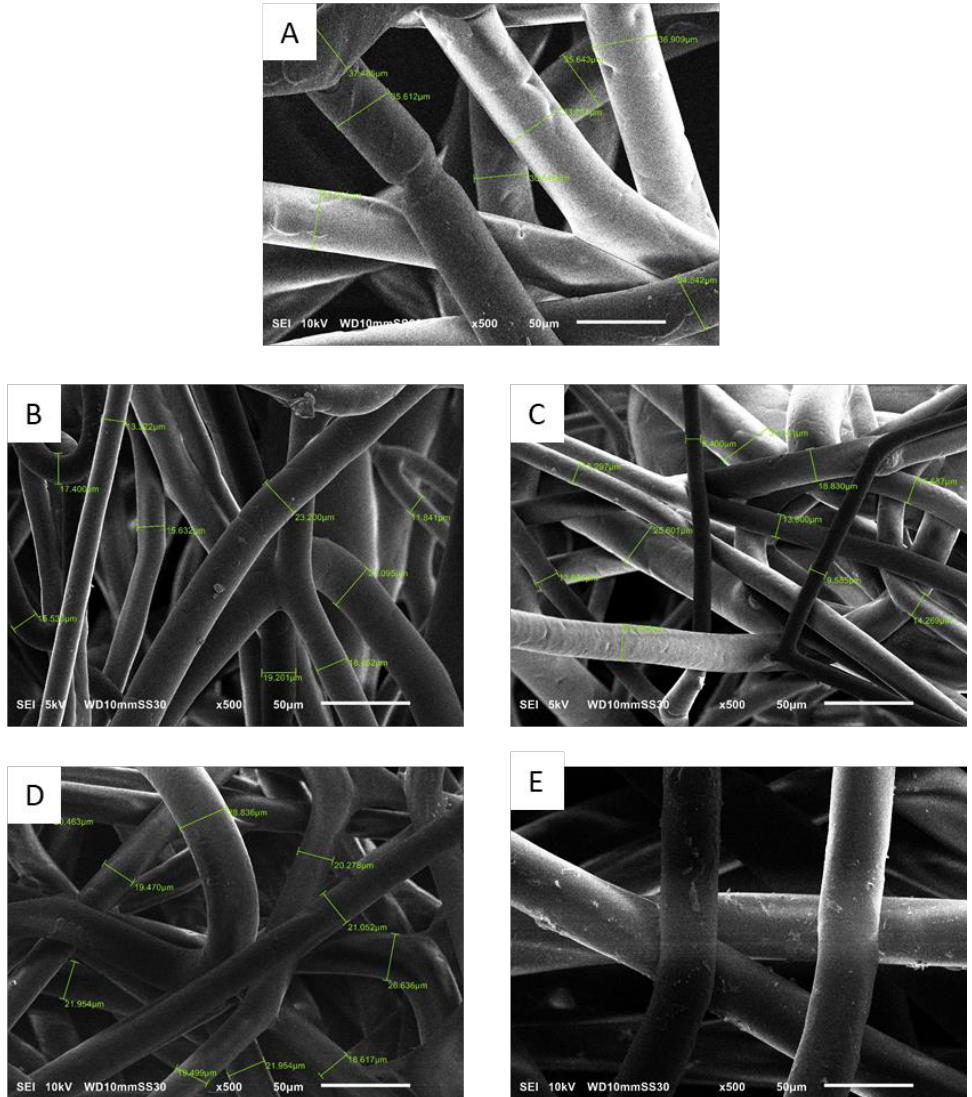
Figure 17. Scanning electron micrographs of PBS melt-electrospun microfibers. ( A ) Pure PBS. ( B ) S1 fibers. ( C ) S3 fibers. ( D ) C1 fibers. ( E ) C3 fibers.